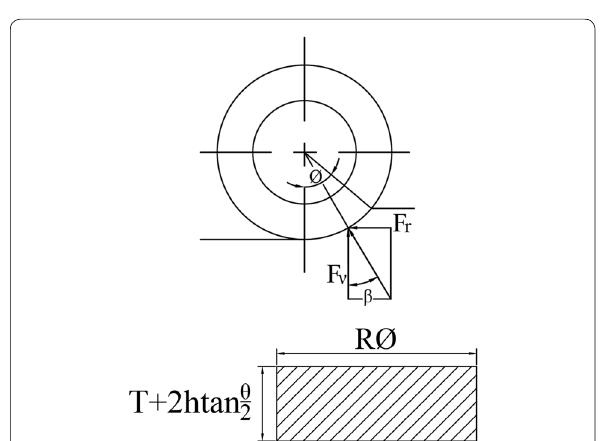
Figure 5 Area pressed by disc cutter in elastic deformation